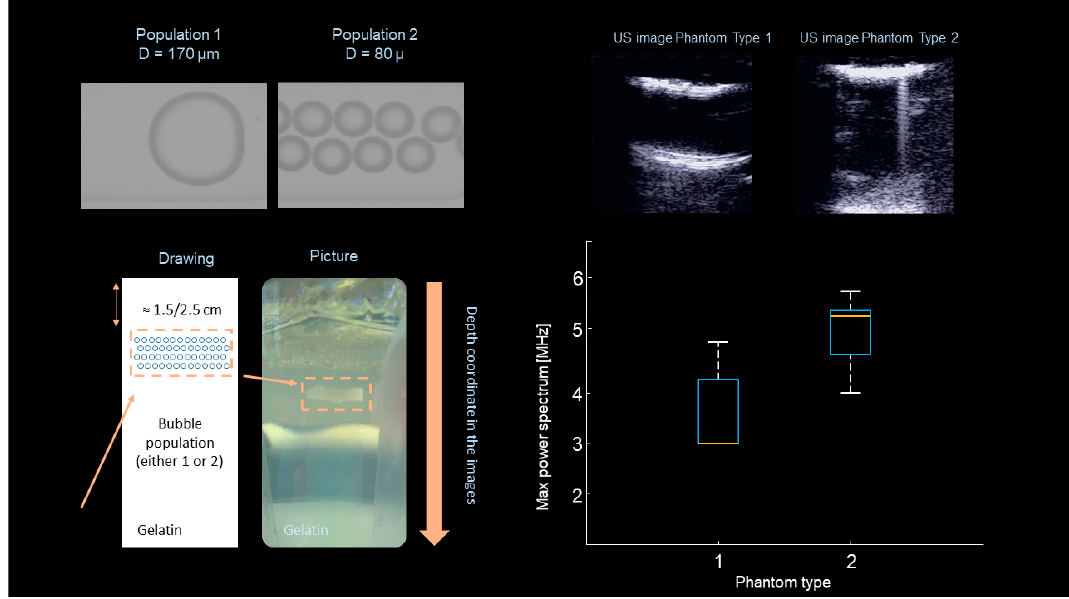
Figure 2. Microscope images of the generated microbubbles, together with a phantom schema and a picture of a lung mimicking phantom (on the left). Ultrasound images generated with standard ultrasound imaging, as obtained with phantom type 1 and 2, together with the results of the frequency analysis of B-lines as obtained with the multi-frequency imaging method.